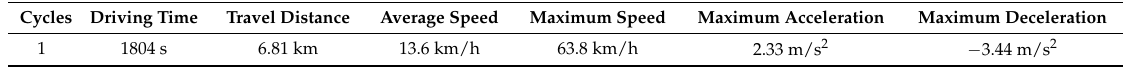
Table 2. The statistics of the Beijing typical citybus driving cycle.